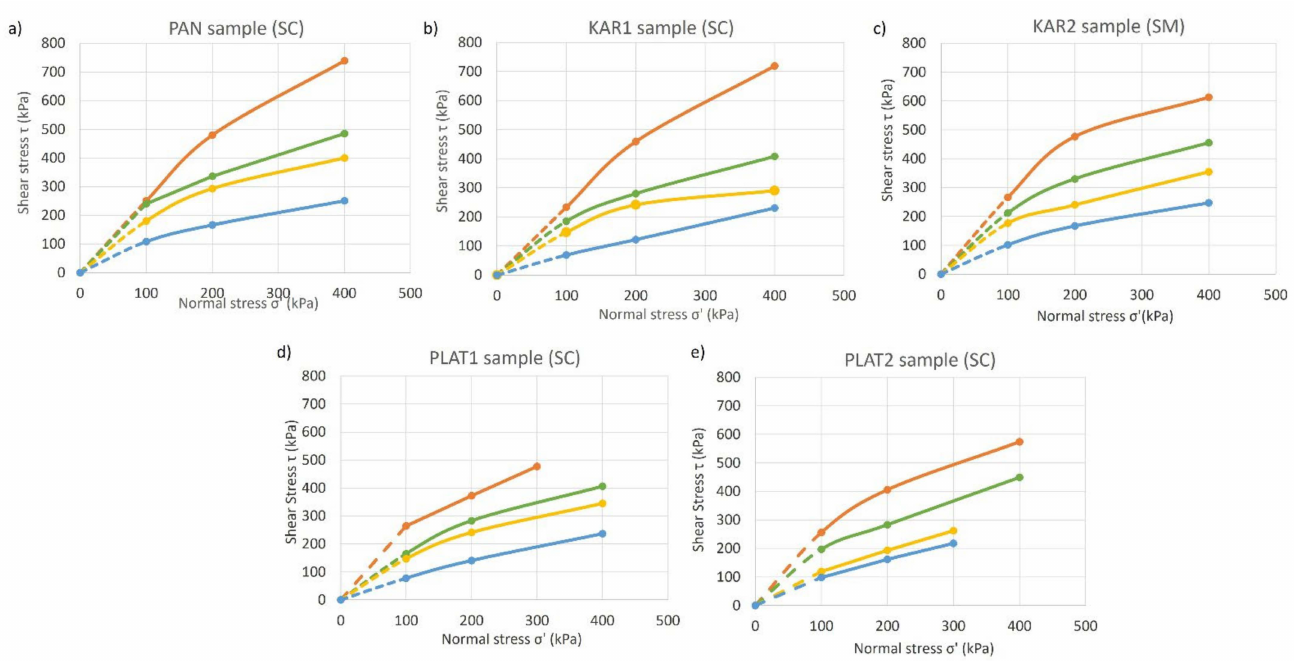
Figure 5. Shear peak stress-normal stress plots in all different saturation states of the dense flysch specimens. PAN ( a ), KAR1 ( b ), KAR2 ( c ), PLAT1 ( d ) and PLAT2 ( e ).